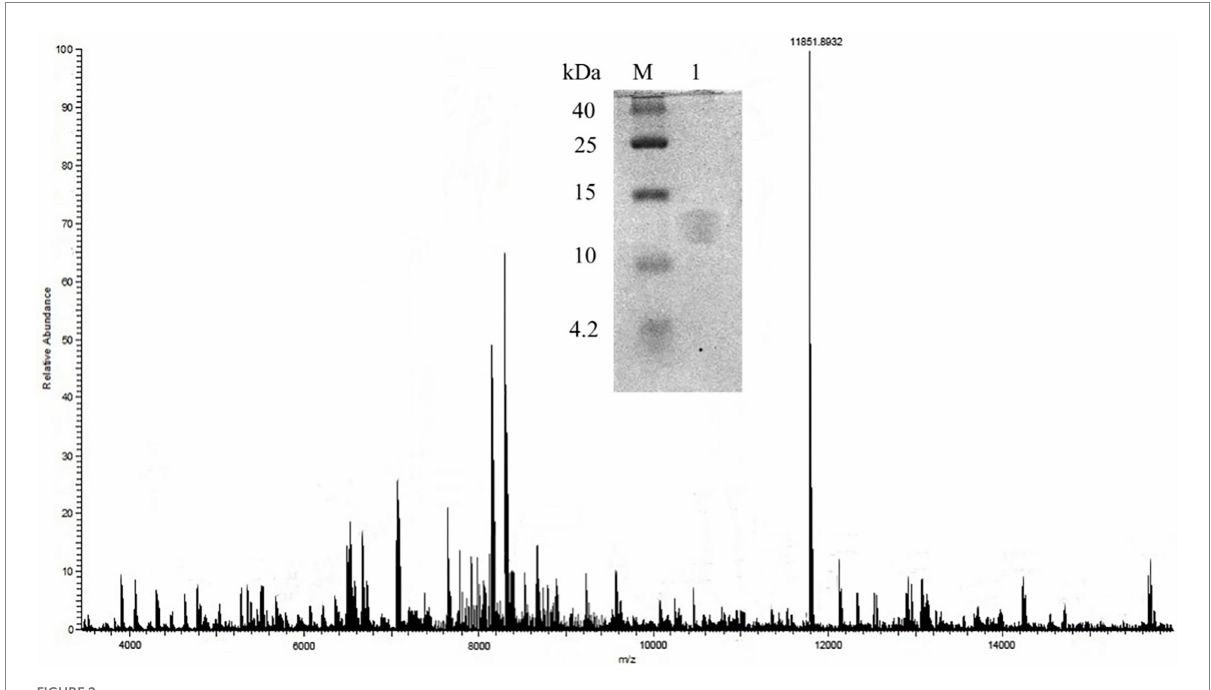
FIGURE 2 Molecule weight of bacteriocin ZFM216 by MALDI-TOF-MS and tricine-SDS-PAGE.